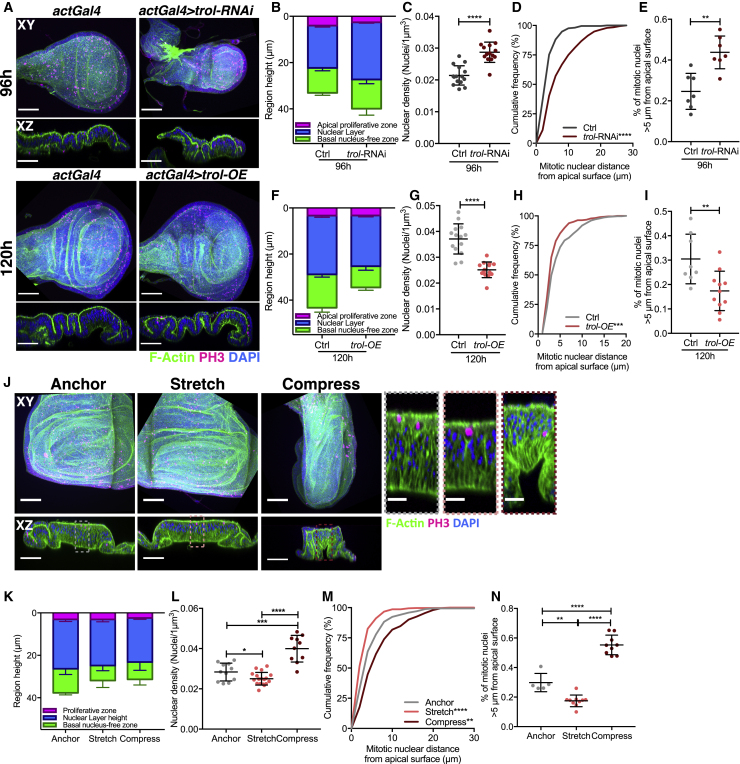
Perturbing Cell Density Influences Mitotic Nuclear Positioning(A) Wing discs stained with phalloidin (green), anti-PH3 (magenta), and DAPI (blue). Top panel, left: 96 h actinGal4 control, right: UAS-trol-RNAi (perlecan) driven by actinGal4 at 96 h. Lower panel, left: 120 h actinGal4 control, right: UAS-trol driven by actinGal4 at 120 h. Top view, projections; lower view, cross-sections.(B and F) Epithelial apico-basal morphology quantification for trol-RNAi (B), trol-OE (F), and respective controls. n = 7 wing discs per condition (B). n = 8 (control) and 11 (trol-OE) (F).(C and G) Nuclear density per μm3 for trol-RNAi (C), trol-OE (G), and respective controls. n = 3 wing discs per condition.(D and H) Cumulative frequency distribution of mitotic nuclear distance, corresponding dot plots, and normalized values in Figures S3D–S3F and S3J–S3L for trol-RNAi (D), trol-OE (H), and respective controls. n = 7 wing discs per condition (D). n = 8 (control) and 11 (trol-OE) (H).(E and I) Percentage of mitotic nuclei more than 5 μm from apical surface for trol-RNAi (E), trol-OE (I), and respective controls. n = 7 wing discs per condition (E). n = 8 (control) and 11 (trol-OE) (I).(J) Wild-type wing discs 120 h AEL following 30-min mechanical perturbation, stained as in (A). Anchor: disc within device without stretch/compression. Right inset: enlarged view of cross-sections highlighting cell height and nuclear density changes.(K) Epithelial apico-basal morphology for anchored, stretched, and compressed conditions. Corresponding data in Figures S3M–S3O.(L) Nuclear density for anchored, stretched, and compressed conditions. n = 3 wing discs per condition.(M) Cumulative frequency distribution of mitotic nuclear distance for anchored, stretched, and compressed conditions with corresponding scatterplot in Figure S3P.(N) Percentage of mitotic nuclei more than 5 μm from apical surface for anchored, stretched, and compressed conditions.(K, M, and N) n = 3 (anchored), 8 (stretched), and 6 (compressed) wing discs.Scale bars, 50 μm (A and J, left) and 10 μm (J, right). Statistical significance: (C), (E), (G), and (I), unpaired t test; (D), (H), and (M), Kolmogorov-Smirnov comparison of cumulative distribution; (L) and (N), one-way ANOVA. ∗p < 0.05, ∗∗p < 0.01, ∗∗∗p < 0.001, ∗∗∗∗p < 0.0001. Error bars: mean ± SD in all plots.